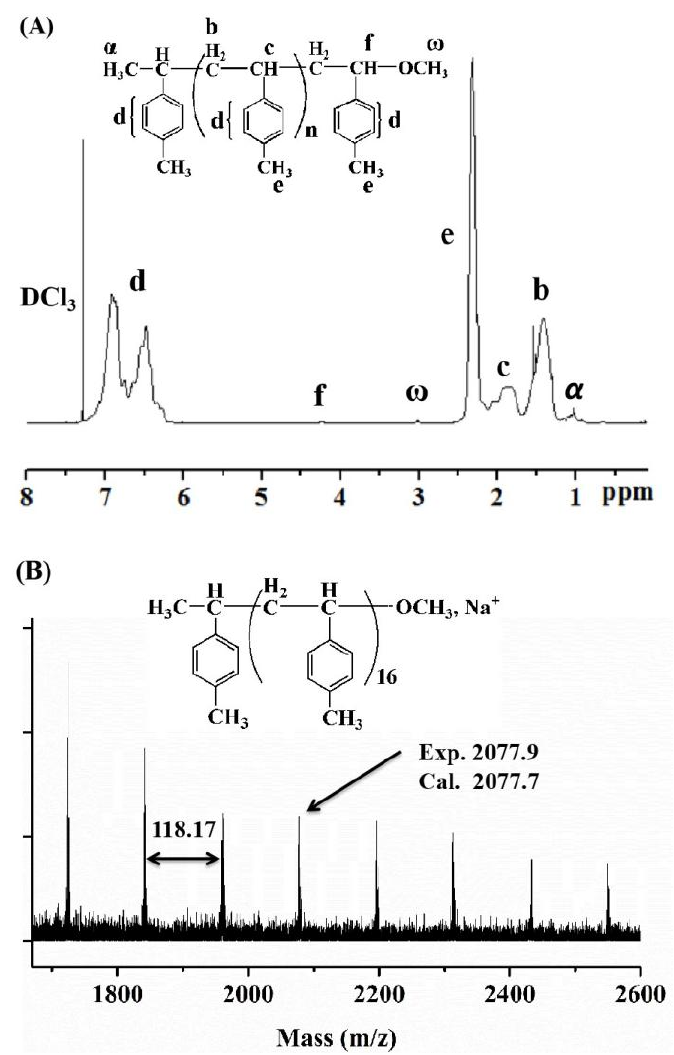
Figure 10. Polymer chain characterization obtained with p ‐ MeStCl/SnCl 4 /DTBP in [Bmim][NTF 2 ]: ( A ) 1 H NMR spectrum; ( B ) MALDI ‐ TOF ‐ MS spectrum.